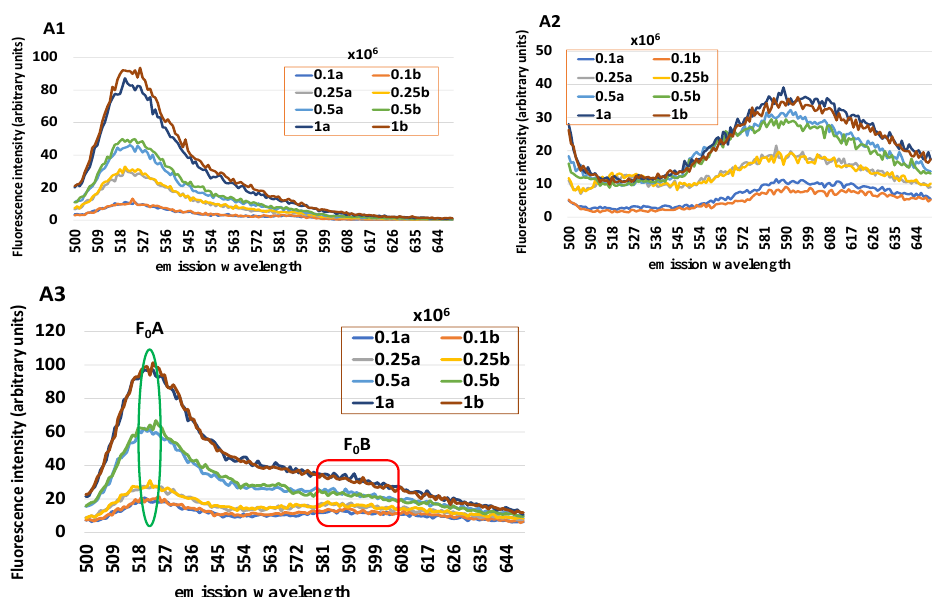
Figure 2. Fluorescence spectra obtained from samples of equine endometrial cells loaded with 2′,7′-dichlorodihydrofluorescein (H 2 DCF-DA) ( A 1), hydroethidine ( A 2), and both the fluorochromes ( A 3), excited at 490 nm wavelength at increasing cell concentration and in duplicate. F 0 A marks the peak of the emission spectrum relative to the DCF (green circle); F 0 B marks the interval of the emission spectrum of the E + used to calculate an average peak value (red square). The normalization of the DCF fluorescence intensity based on the number of cells of the sample is obtained from the F 0 A/F 0 B ratio.